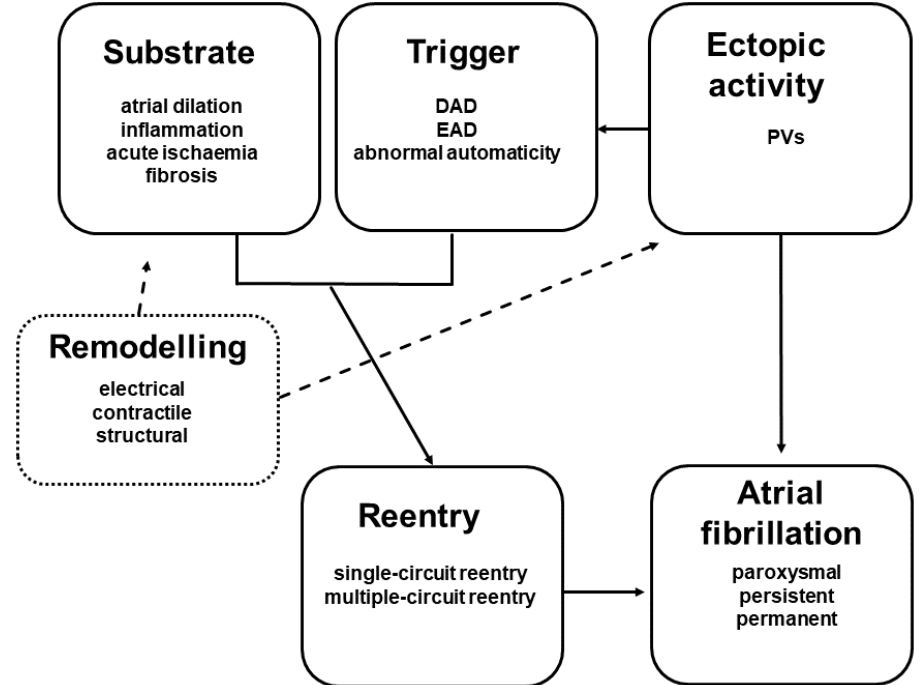
Figure 1. General scheme presenting the main factors, which are implicated in provoking and sustaining atrial fibrillation (AF). AF is usually initiated by spontaneous ectopic beats (extrasystole) originating from a pacemaker region (PVs, left upper pulmonary vein) and later is maintained by mechanism of atrial remodelling. The atrial fibrillation forms (lone, persistent and permanent) are promoted by single/mother wave and/or multiple wave/circuit re-entries. The main factors that may promote reentry are atrial ischaemia and inflammation, while the structural/morphological remodellings are sustained by atrial (micro)fibrosis and left atrial dilation. DAD and EAD—delayed and early afterdepolarization; PVs—pulmonary veins.